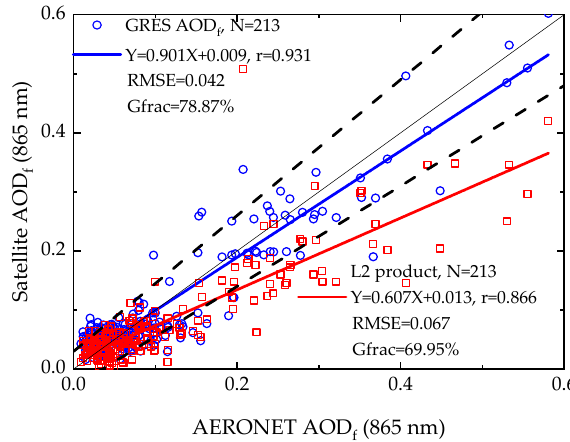
Figure 7. The scatter plots for the GRES AOD f and PARASOL product against AERONET measurements.